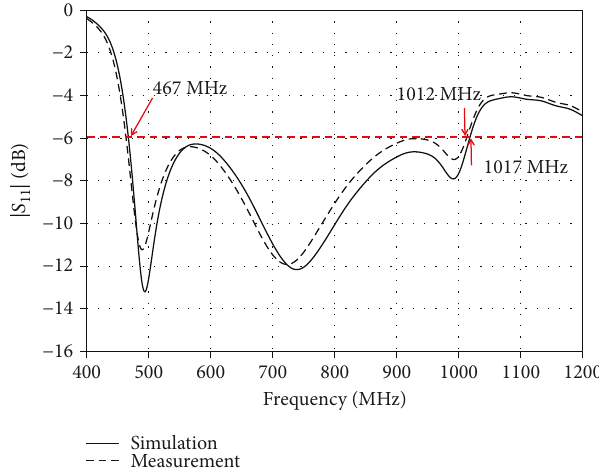
Figure 12: The simulated and measured | S MLA relative to frequency.